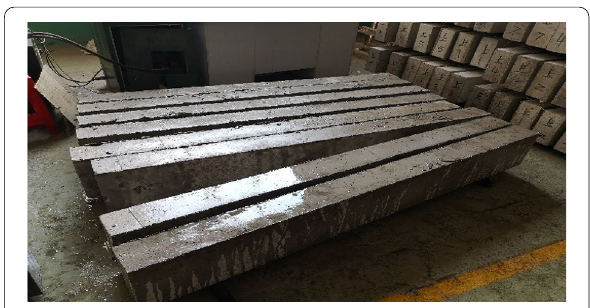
Fig. 3 Cured concrete beams after pouring.